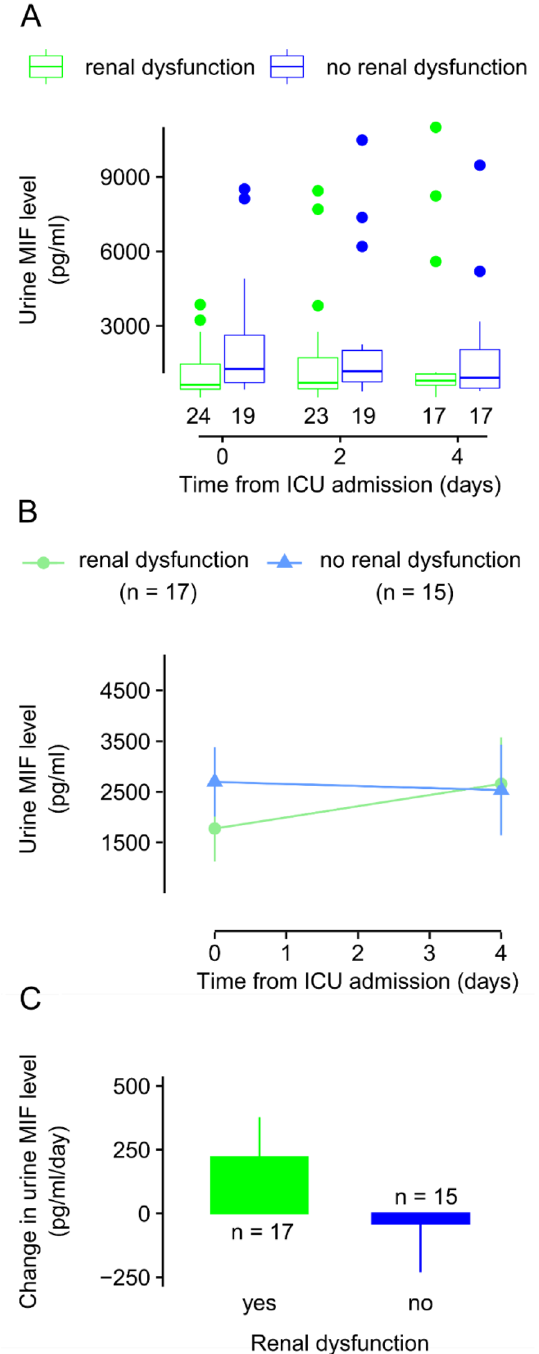
Figure 6. The kinetics of urine macrophage migration inhibitory factor (MIF) levels in septic patients with and without renal dysfunction at the intensive care unit (ICU). ( A ) Box plot of urine levels of MIF in septic patients with and without renal dysfunction on day 0, 2, and 4 from admission to the ICU (for explanation of symbols, see Fig. 2). ( B ) The mean absolute urine levels of MIF in septic patients with and without renal dysfunction on day 0 and 4 from admission to the ICU. ( C ) The mean daily changes of urine MIF levels in septic patients with and without renal dysfunction. The number of patients is indicated in the figure in each